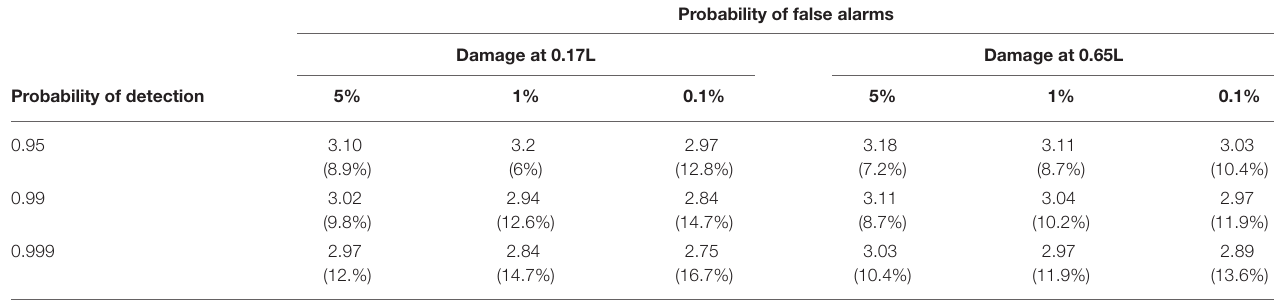
TABLE 2 | Safety Index (and percentage of damage) as a function of the probability of detection and the probability of false alarms—wavelets. Probability of false alarms Damage at 0.17L Damage at 0.65L Probability of